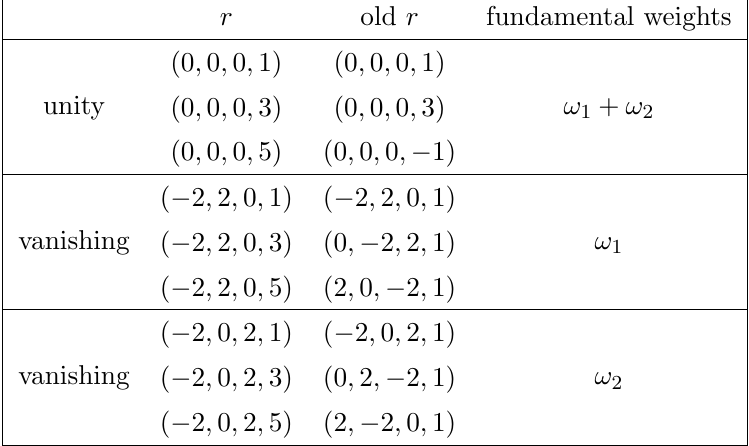
Table 6 . The r -(cid:12)elds of the n = 3 model and the fundamental weights of a 2 which induce the embedding (cid:30) : Q _ , ! P . The old r -(cid:12)elds are from our previous paper [25]. They are equivalent with the r in the second column by 2 C (cid:1) n